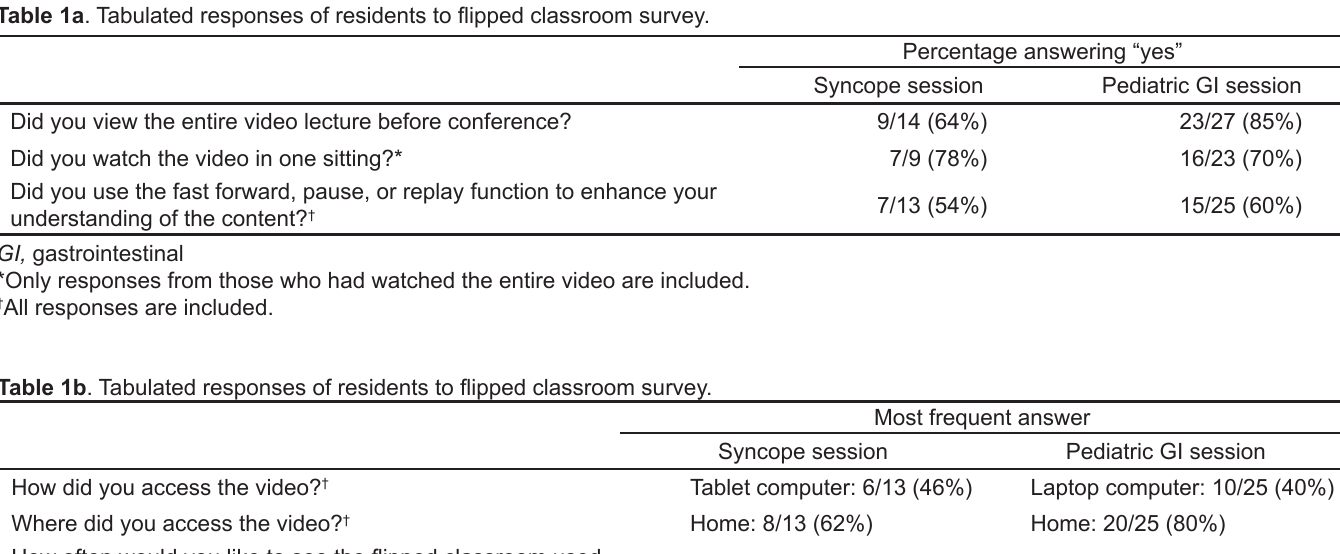
GI, gastrointestinal † All responses are included.